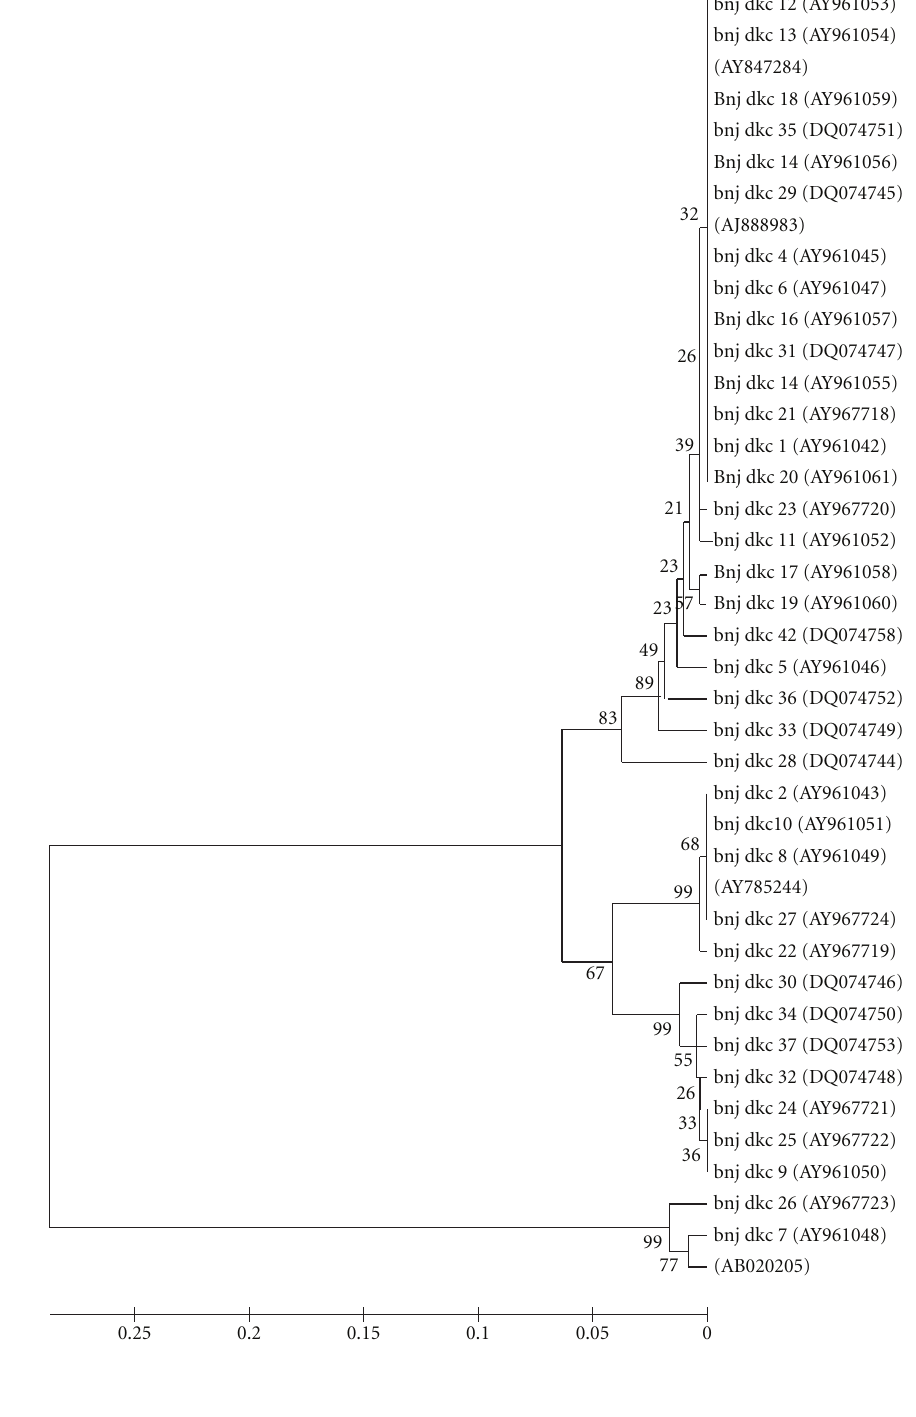
Figure 2: Multiple sequence alignment of retrieved sequences and homology tree constructed by using MEGA 4.0.2 software with bootstrap values for 38 bacterial isolates recovered from casing soils and their comparison with sequences (AB020205, AY847284, AJ888983, and AY785244) borrowed from the